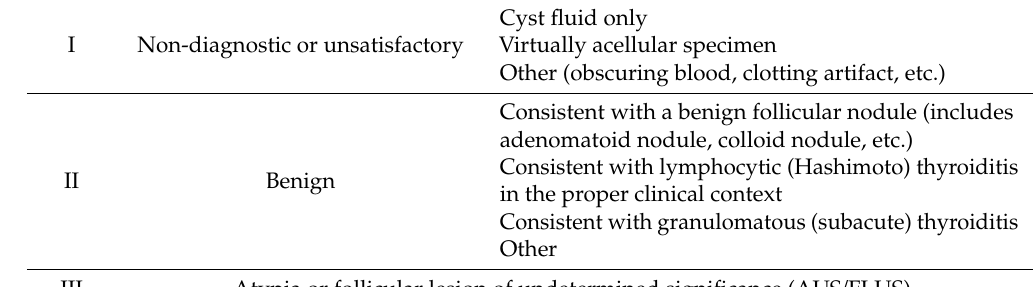
Table 3. The Bethesda System for Reporting Thyroid Cytopathology (TBSRTC)